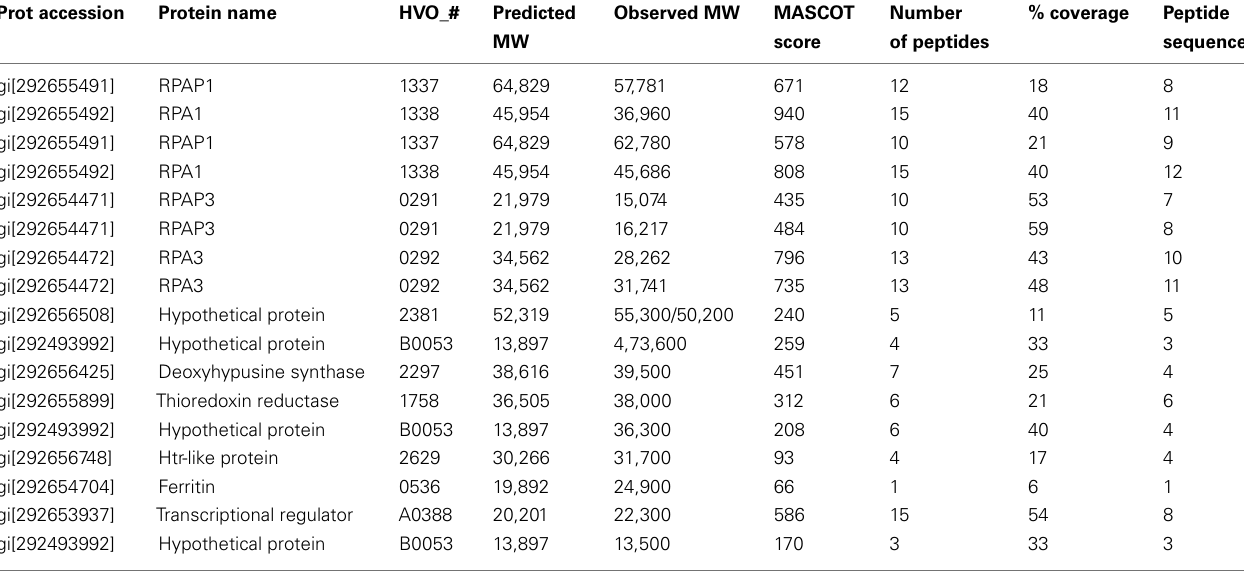
TableA1 | Identification of proteins present in cellular soluble fraction after purification by affinity chromatography on a Ni 2+ chelating